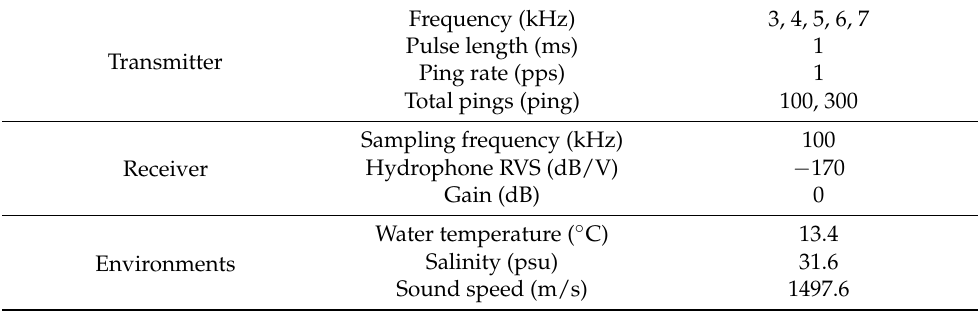
Table 2. Transmitter, receiver, and measured environmental factors for sound attenuation by fish